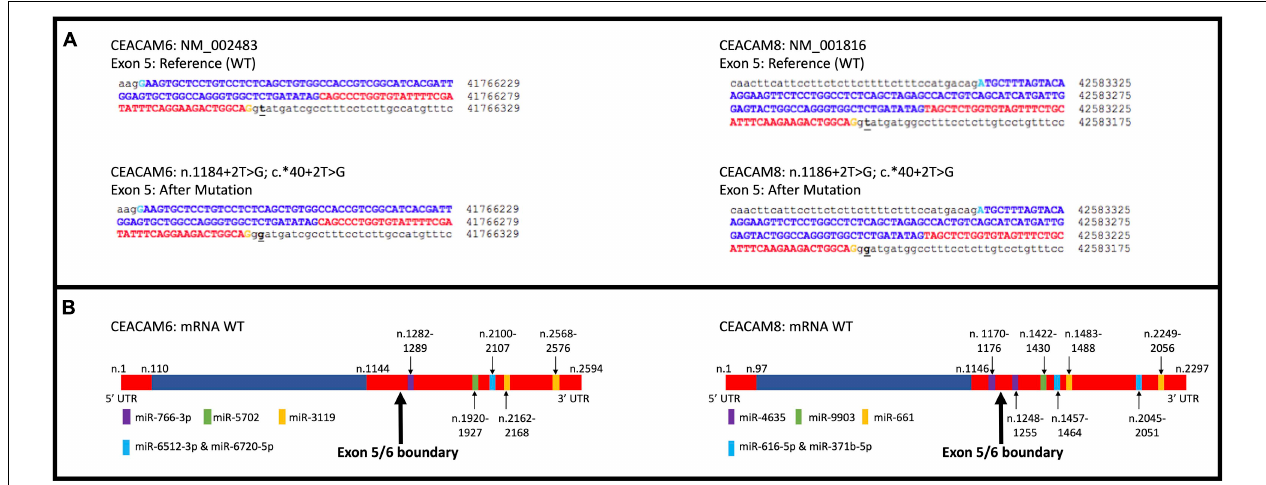
FIGURE 4 | CEACAM6 and CEACAM8 significant splicing mutations. (A) Depiction of the change in genomic sequence with splice site mutation. (B) Depiction of the top five miRNA binding sites for CEACAM6 and CEACAM8 within the mature mRNA. Blue is coding and red is